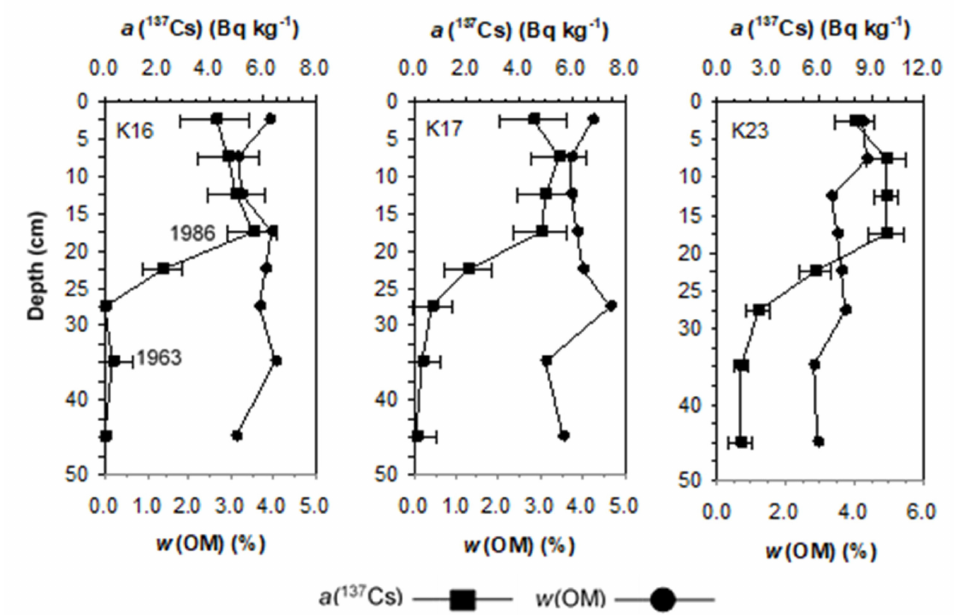
Figure 5. 137 Cs massic activity profiles reflecting increased sediment input and/or sediment mixing and organic matter mass fraction profiles. Measurement uncertainties are expressed with k = 2 for normal